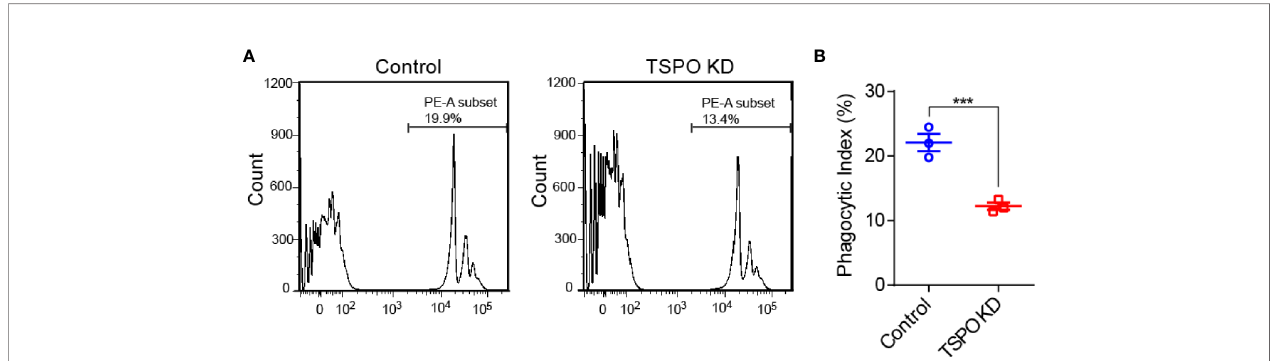
FIGURE 3 | TSPO de fi ciency impairs phagocytosis in BV2. (A, B) Phagocytosis was measured by incubating latex beads in shvector and shTSPO BV2 cells. Data are expressed as the mean ± SEM. Data were analyzed using one-way ANOVA. ***p <